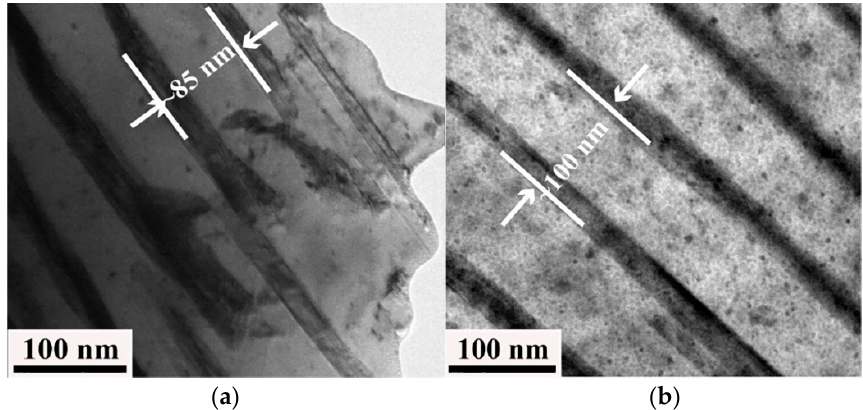
Figure 9. TEM bright-field image of the alloy Cu–15Ni–8Sn–xP: ( a ) x = 0; ( b ) x = 0.2 [37]. 4.5. V